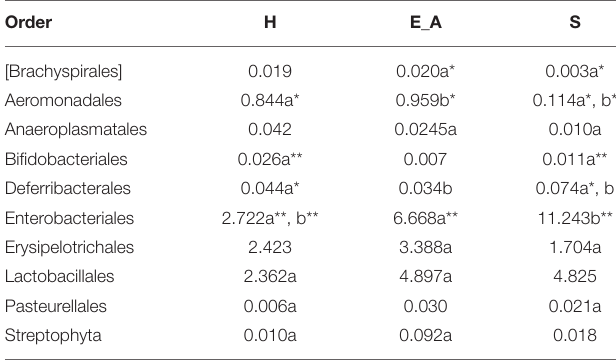
results at the genus level showing a lower abundance of Mucispirillum (Fam. Deferribacteraceae , phylum Deferribacteres)